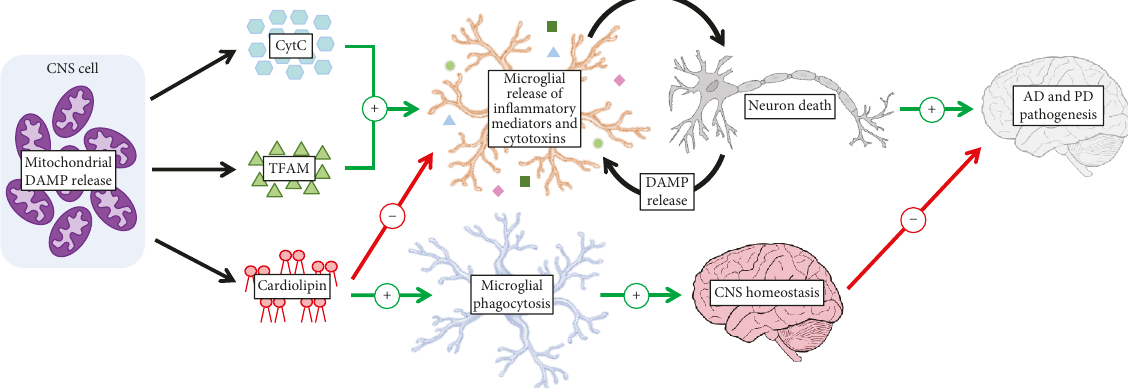
Figure 1: Mitochondrial damage-associated molecular patterns (DAMPs) cytochrome c (CytC), mitochondrial transcription factor A (TFAM), and cardiolipin can be released into the central nervous system (CNS) intercellular space where they regulate microglial phagocytosis and the release of in fl ammatory mediators by microglia. AD=Alzheimer ’ s disease; PD=Parkinson ’ s